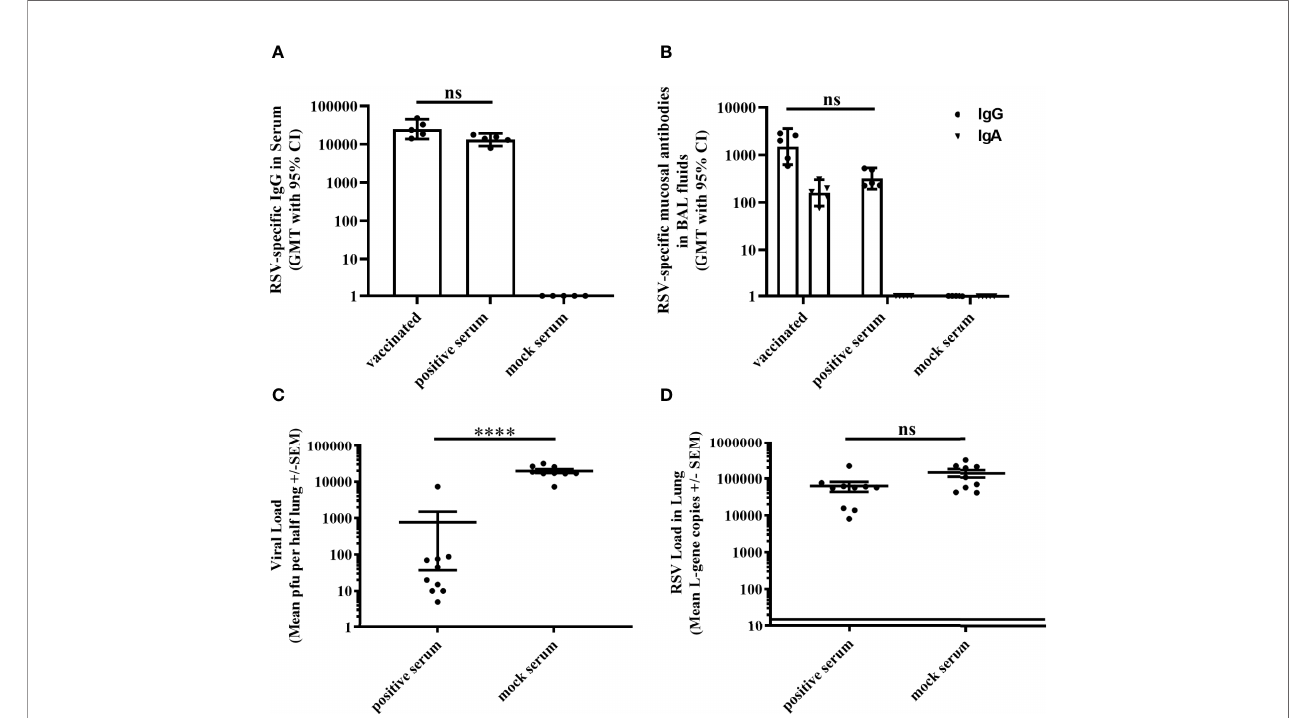
FIGURE 3 | Ef fi cacy of passively transferred RSV-speci fi c antibodies. Either BALB/c mice ( n = 5) were vaccinated (IN) twice 3 weeks apart with 1 × 10 8 TCID 50 MVA-RSV or non-vaccinated BALB/c mice received 1 ml of serum (IP) from MVA-RSV-vaccinated (positive serum) or mock-vaccinated control mice (mock serum) 1 day before